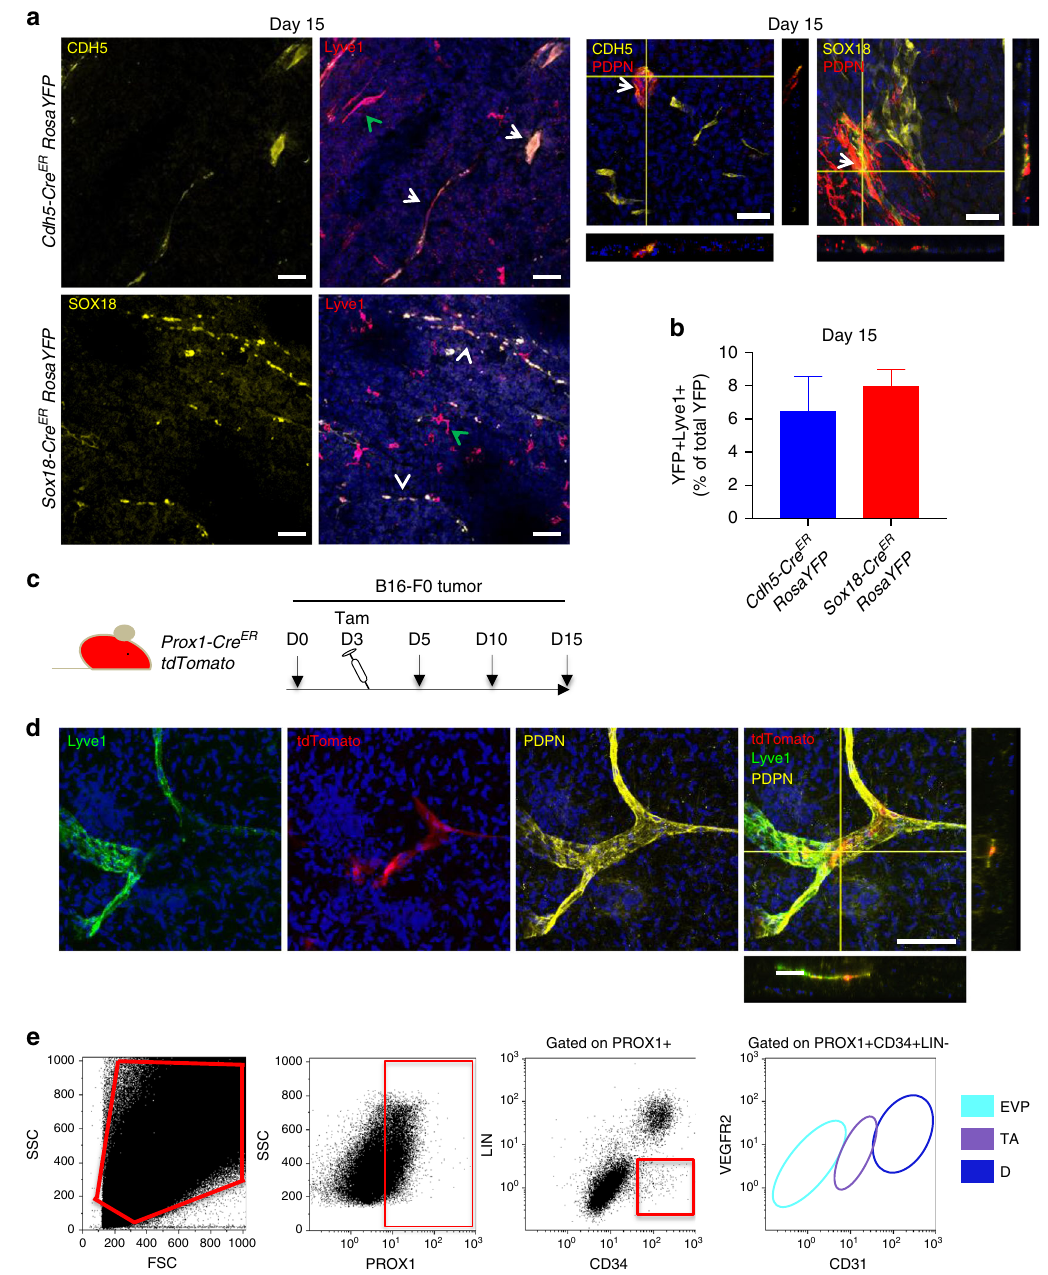
Fig. 4 EVPs contribute to lymphatic vascular beds but do not originate from lymphatics. a , b Representative micrographs of tumor sections taken from Cdh5-Cre ER RosaYFP and Sox18-Cre ER RosaYFP lineage tracing models. At day 15 YFP + vessels co-localized with lymphatic marker Lyve1 (white arrow) and Podoplanin (PDPN). Green arrows represent Lyve1 + vessels that are not YFP + ( n = 5). c Schematic diagram of the Prox1-Cre ER tdTomato lineage tracing model employed with B16-F0 melanoma cells injected at day 0 (D0), with mice receiving tamoxifen (Tam) 3-days post tumor inoculation ( n = 5). d Lyve1 + PDPN + vessels co-localized with Tomato + (Prox1) vessels. e Flow cytometry plots demonstrating that Prox1 + CD34 + LIN- cells do not contribute to the endothelial hierarchy. Results presented as mean ± SEM. Scale bar represents 150 μ m. EVP endovascular progenitor, TA transit amplifying,